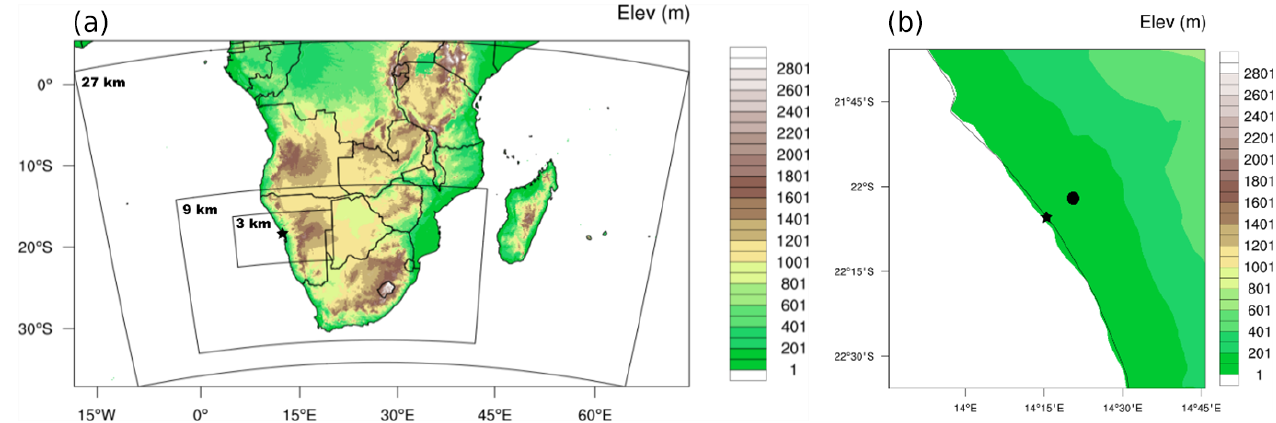
Figure 1. (a) WRF model domains and (b) insert showing the Henties Bay site (star) and inland point (circle) from the model which is used during the evaluation of the